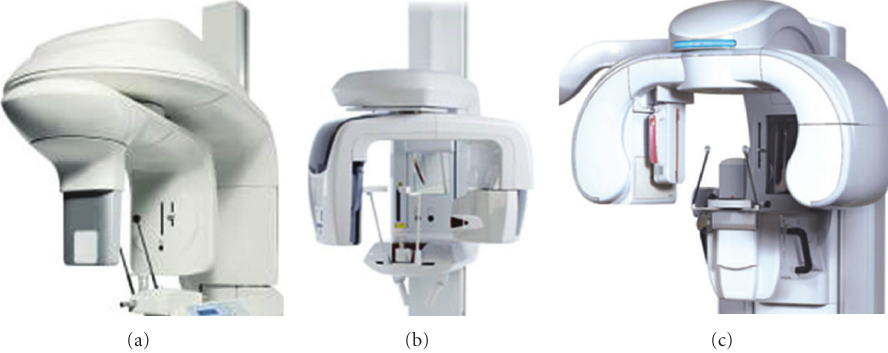
Figure 1: Examples of hybrid CBCT units. (a) KODAK Dental Imaging 9000 3D, (b) Veraviewepocs 3D, and (c) Picasso